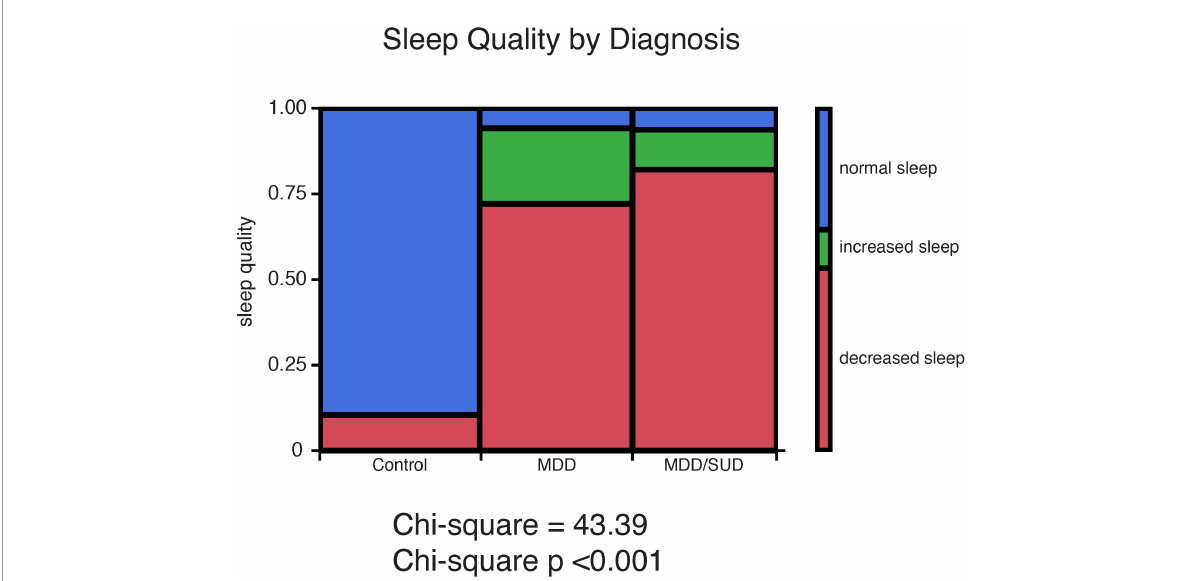
FIGURE1 History of sleep disturbances in subjects with SUD and subjects with MDD. Sleep quality ratings representing presence or absence of history of sleep disturbances were obtained from medical records and family interviews of each donor. Sleep quality was characterized as normal sleep, decreased sleep, or increased sleep. Chi-square analysis revealed a significant effect of diagnosis group (Controls, MDD or SUD and SUD with MDD) on sleep quality. Subjects with MDD and subjects with MDD/SUD had higher prevalence of decreased sleep as well as a smaller group of subjects with increased sleep.